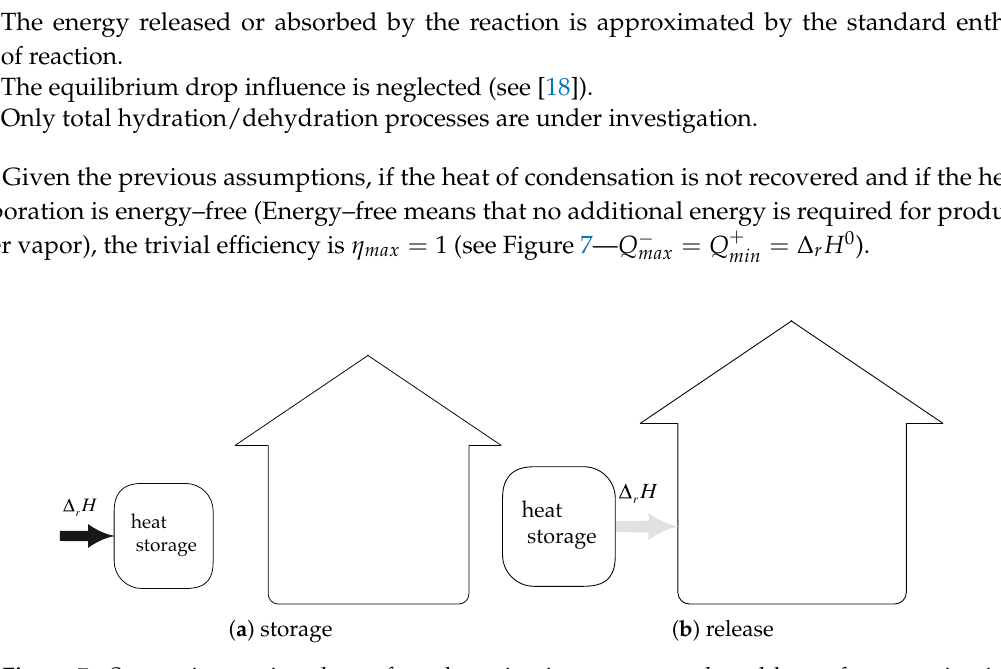
Figure 7. System integration: heat of condensation is not recovered, and heat of evaporation is energy–free: η max = 1.